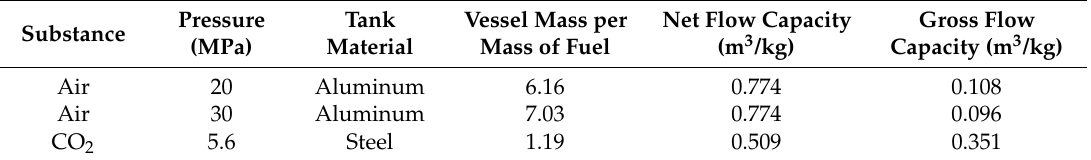
Table 5. Vessel mass per mass of fuel and net and gross flow capacities for air and carbon dioxide, based on